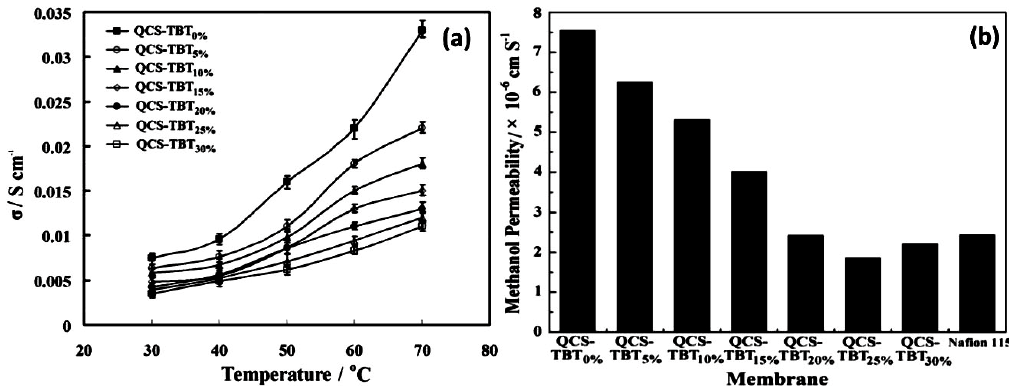
Figure 16. ( a ) Anionic conductivities of the QCS ‐ TBTx% membranes (QCS ‐ TBT0%, QCS ‐ TBT5%, QCSTBT10%, QCS ‐ TBT15%, QCS ‐ TBT20%, QCS ‐ TBT25%, and QCS ‐ TBT30%) with different TBT content as a function of temperature; ( b ) methanol permeability of Nafion ® 115 and QCS ‐ TBT x% hybrid membranes (QCSTBT 0%, QCS ‐ TBT 5% , QCS ‐ TBT 10% , QCS ‐ TBT 15% , QCS ‐ TBT 20% , QCS ‐ TBT 25% , and QCS ‐ TBT 30% ). Reproduced with permission from [107]. Copyright Elsevier, 2015.